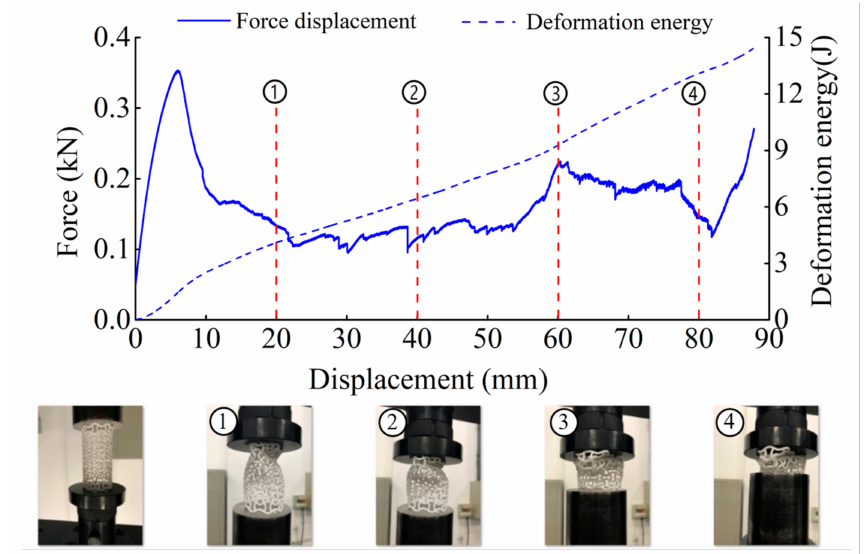
Figure 8. Deformation process of CCHT2 (1–4 stages of deformation during quasi-static compression test).